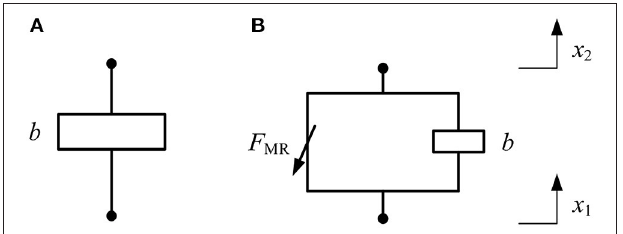
FIGURE 2 | Ideal model: (A) the conventional inerter and (B) the SAI.